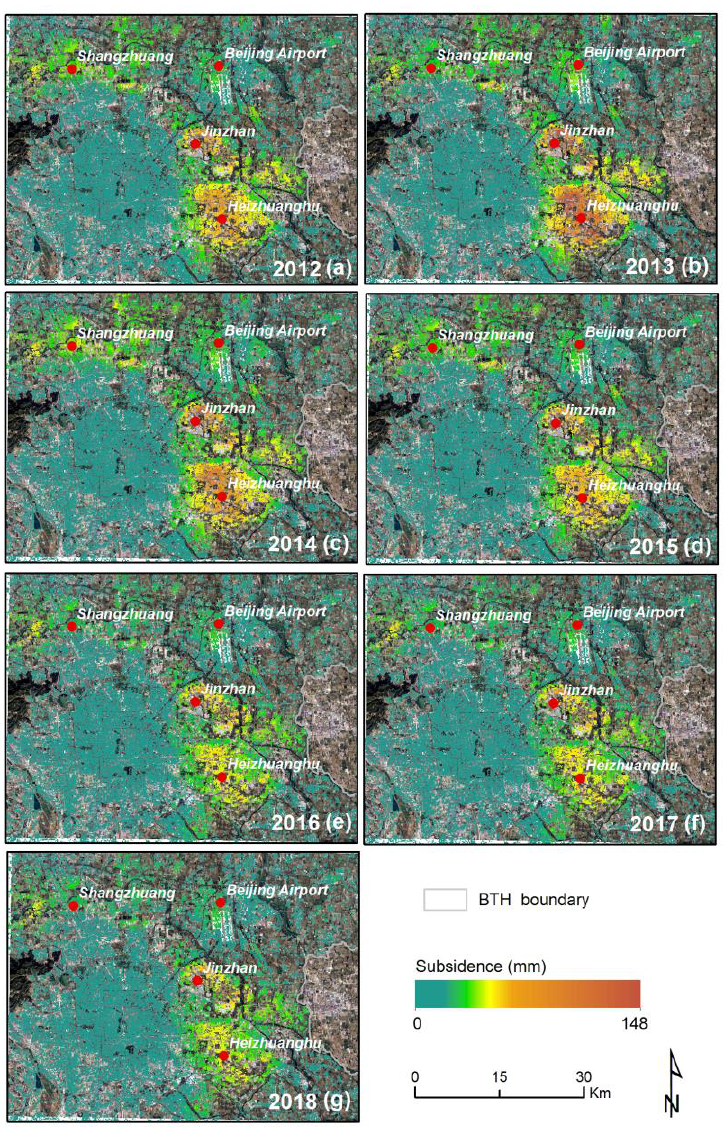
Figure 4. The annual land subsidence in the typical Beijing region. The subsidence in ( a )–( d ) is based on results from the Radarsat-2 data and ( e )–( g ) show the results from the Sentinel-1 data, respectively. The four red circles are the locations of the subsidence features.